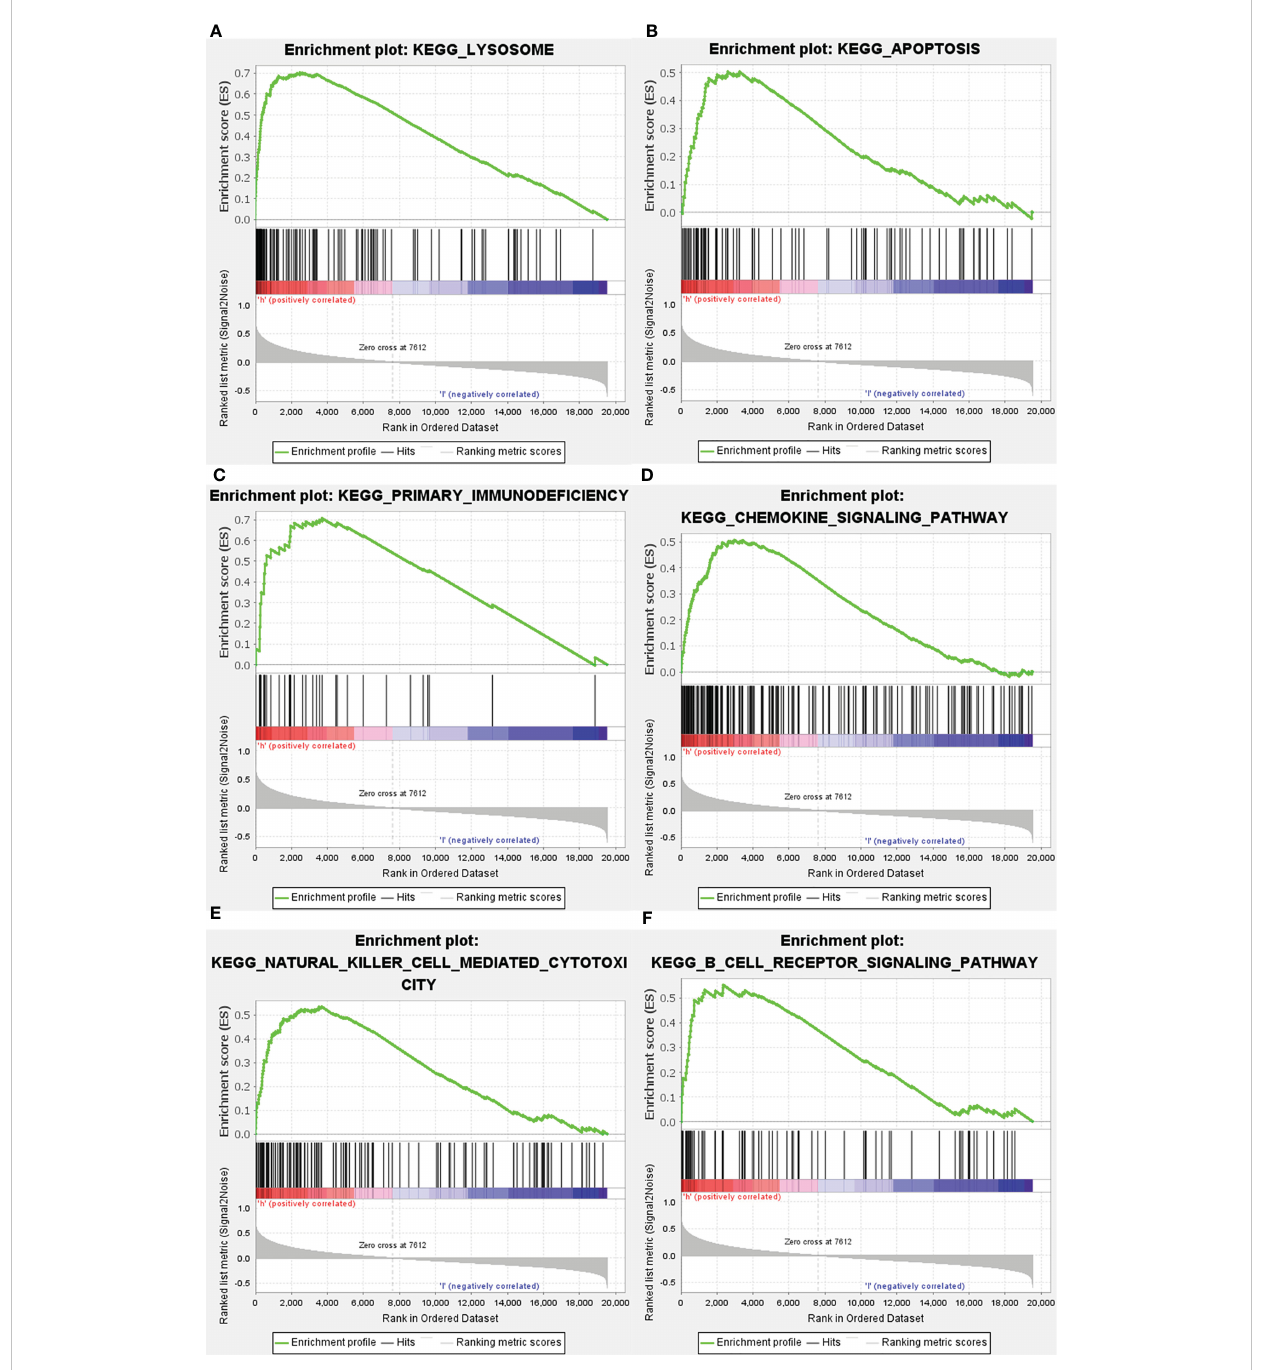
FIGURE 6 Enrichment plots from gene set enrichment analysis (GSEA). GSEA results showing differential enrichment of genes in KEGG with high GRN expression: lysosome (A) , apoptosis (B) , primary immunode fi ciency (C) , chemolzine signaling pathway (D) , natural killer cell mediated cytotoxicity (E) and B cell receptor signaling pathway (F) were signi fi cantly differential enrichment based on NES, NOM P value, and FDR